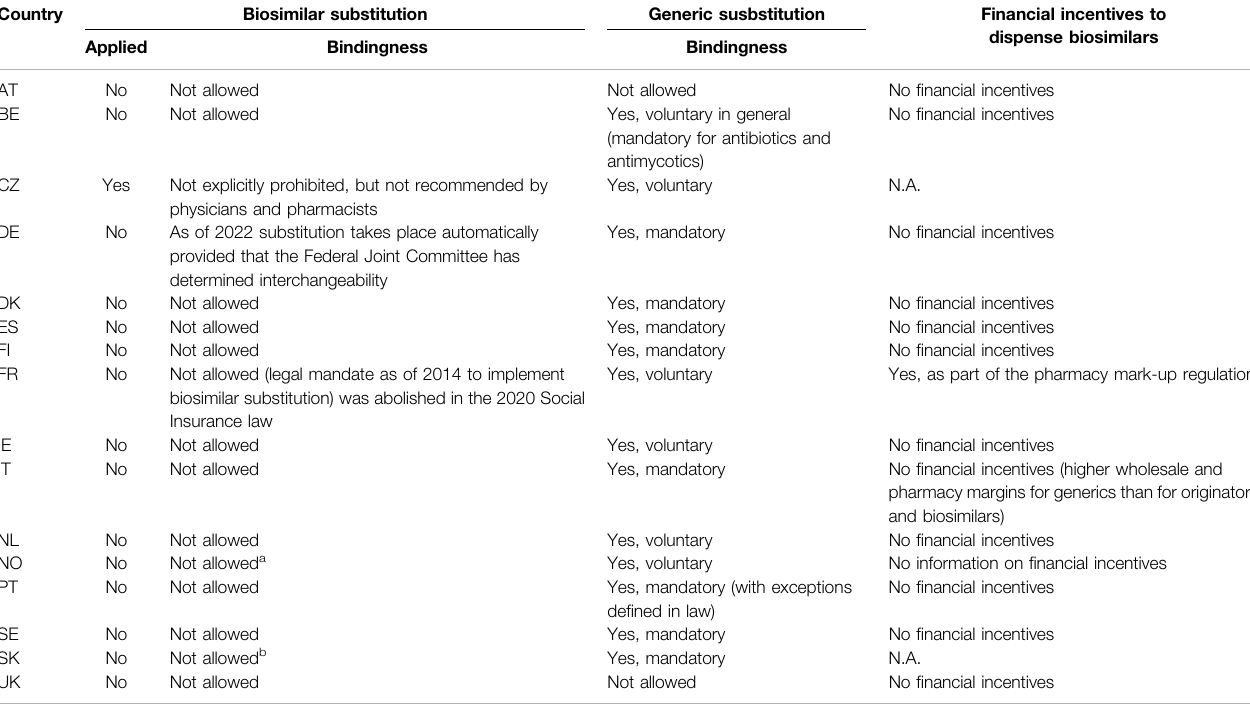
TABLE 5 | Measures to endorse the use of biosimilar medicines at community pharmacy.